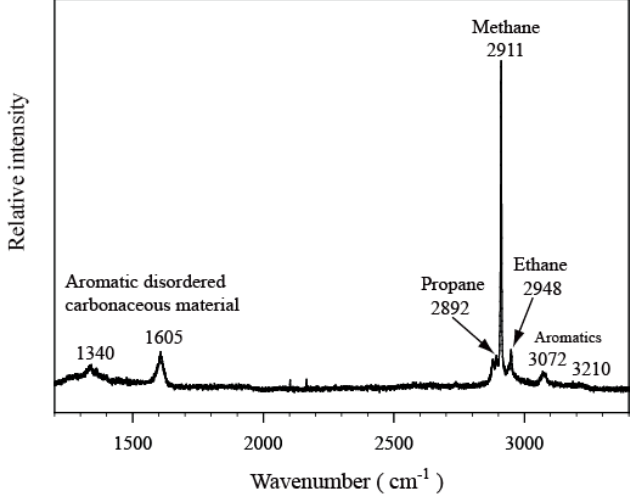
Figure 14. Laser Raman spectrum of a hydrocarbon inclusion with characteristic bands indicative of the presence of methane, ethane, propane and aromatic